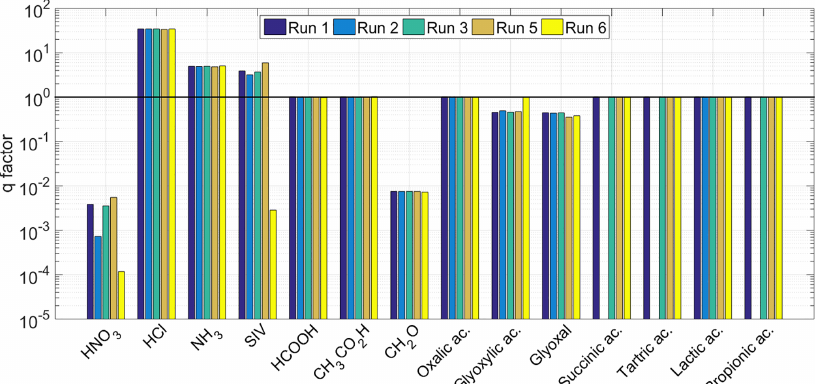
Figure 8. Partitioning coefficients q (log scale) calculated for a selection of compounds during Run 1 (reference), Run 2 (no particle scav- enging), Run 3 (increased quantities of organics in the particle phase), Run 5 (decreased cloud liquid water content and droplet radius) and Run 6 (pH =